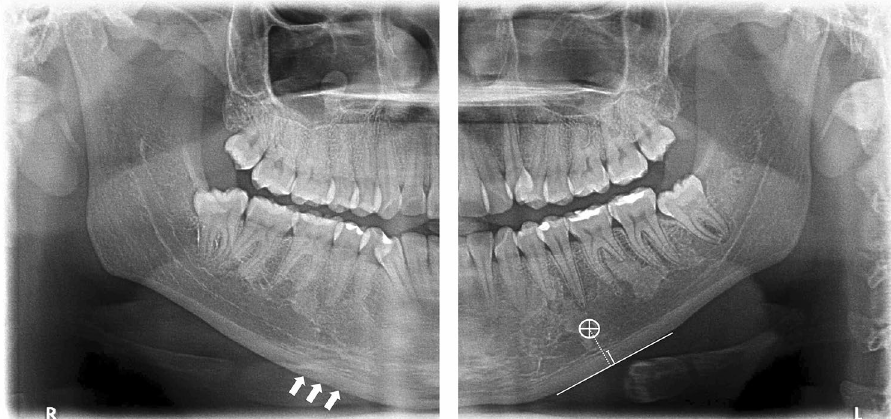
Figure 3. Panoramic radiograph representing the MCI assessment and tracing for MCW measurement. The left cropped DPR shows the inferior cortical border of the mandible that was evaluated qualitatively as C1 = considered homogeneous, C2 = mild erosions and C3 = multiple erosions appearance, clearly porous. The right cropped DPR radiograph showing the mandibular cortical width index. The mental foramen is delimited on the radiograph, and two parallel lines are drawn to demarcate the upper and lower edges of the mandibular cortex. A third line is drawn in the center of the mental foramen and perpendicular to the two cortical lines. The cortical width is determined by measuring the parallel line that surrounds the two structures.